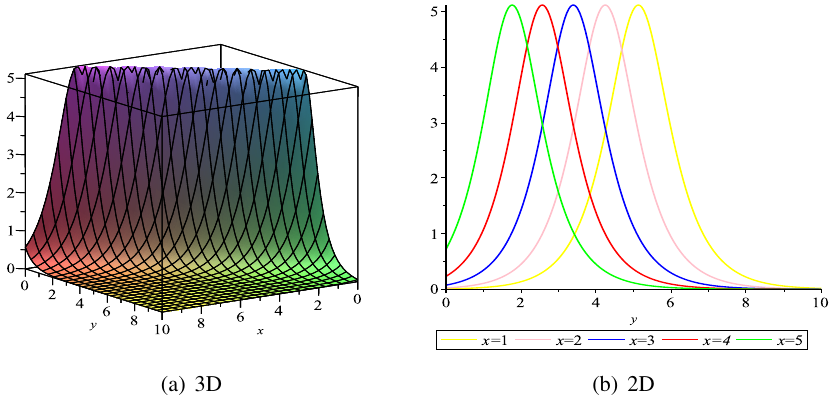
Fig. 1 The solitary wave solution (40) for k 1 = 1 , k 2 = 1 . 2 , k 3 = 2 . 2 , c 2 = 1 . 5 , δ = 2 . 5 , α = 0 . 95.